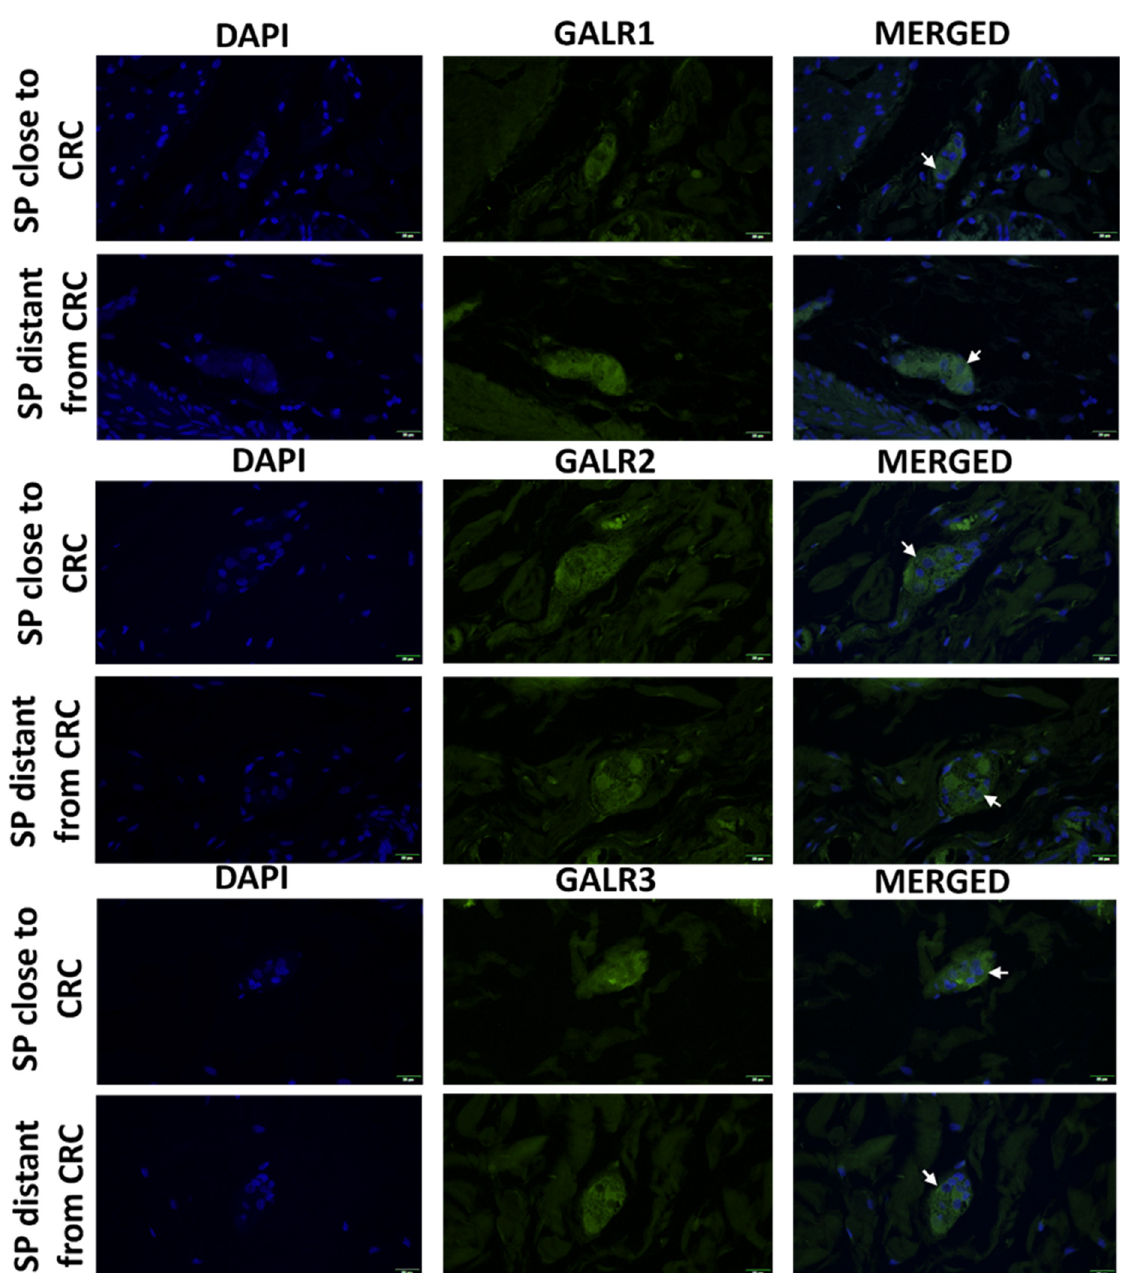
Figure 7. Immunolocalization of galanin receptors (GALR1, GALR2, and GALR3) in submucosal plexuses (SP) close and distant to tumour tissue of colorectal cancer patients (n = 5). Neurons expressing respective GALRs are marked by arrows. Total magnification: 400×.